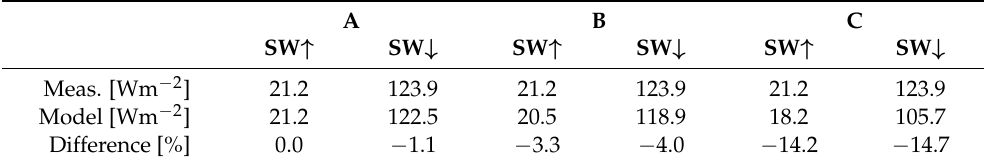
Table 3. Modeled SW irradiances (upward and downward) with the different aerosol optical proper- ties found in the literature (Table 1, columns A, B, C) and comparison with ground-based measure- ments from 21 August